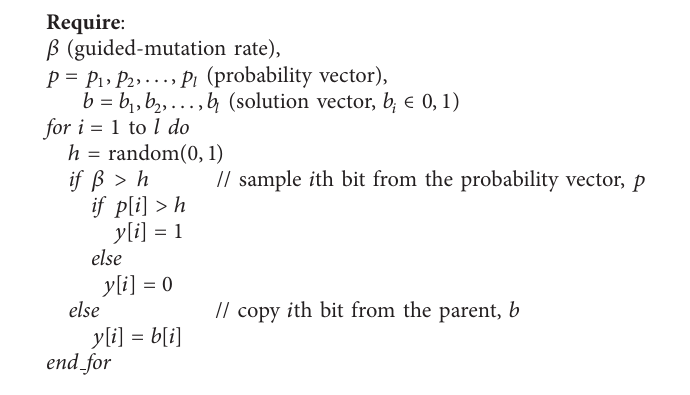
Pseudocode 2: The guided-mutation